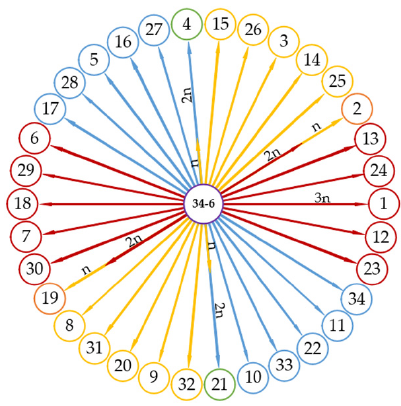
Figure 2. Slot distribution to phases of M 3 .